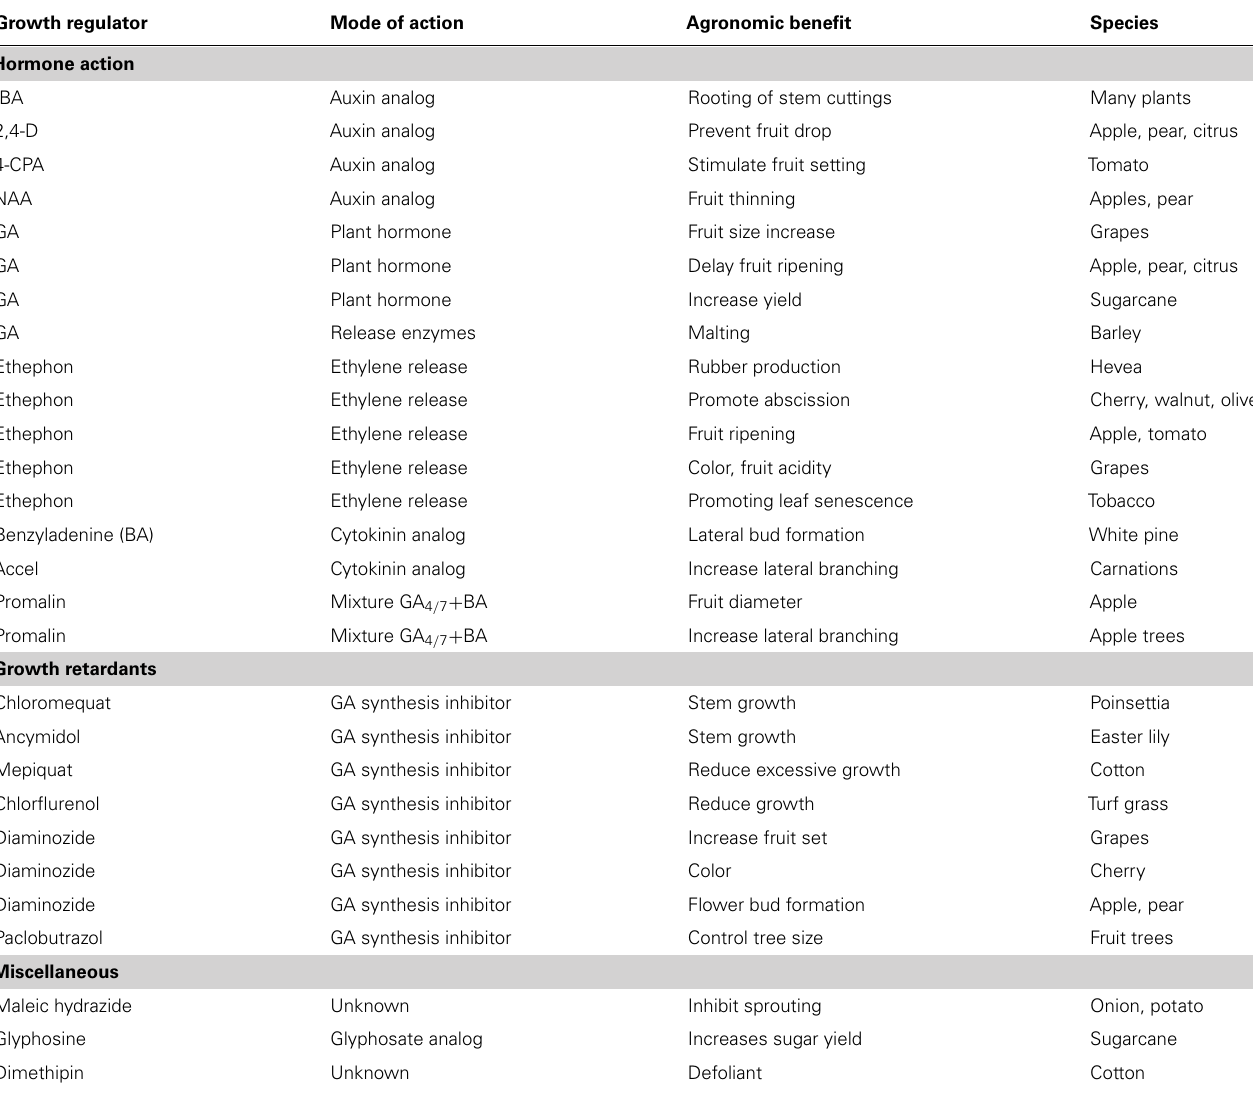
TableA1 | Plant growth regulators used in